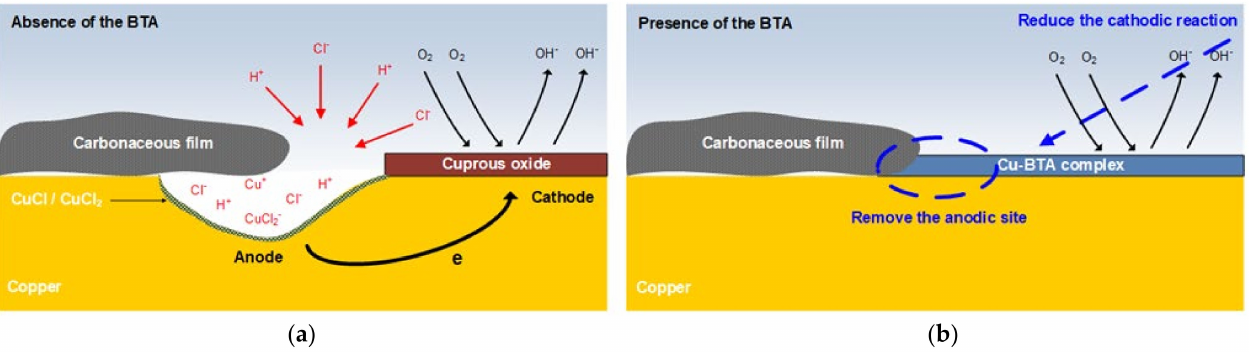
Figure 9. ( a ) Schematic diagram of localzed corrosion mechanism at the boundary part of the carbonaceous film of copper in the absence of BTA; ( b ) schematic diagram of mechanism to prevent localized corrosion at the boundary part of the carbonaceous film of copper in the presence of